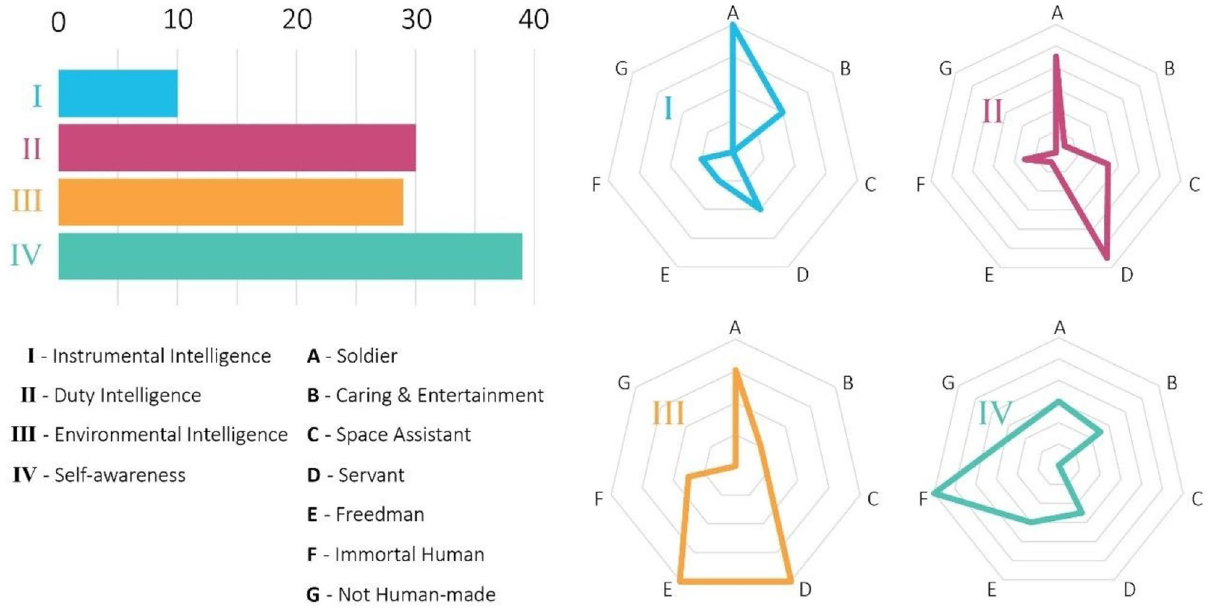
Fig. 5 Radar chart of the robots’ artificial intelligence level, including the number of robots as well as the distribution of their roles in each